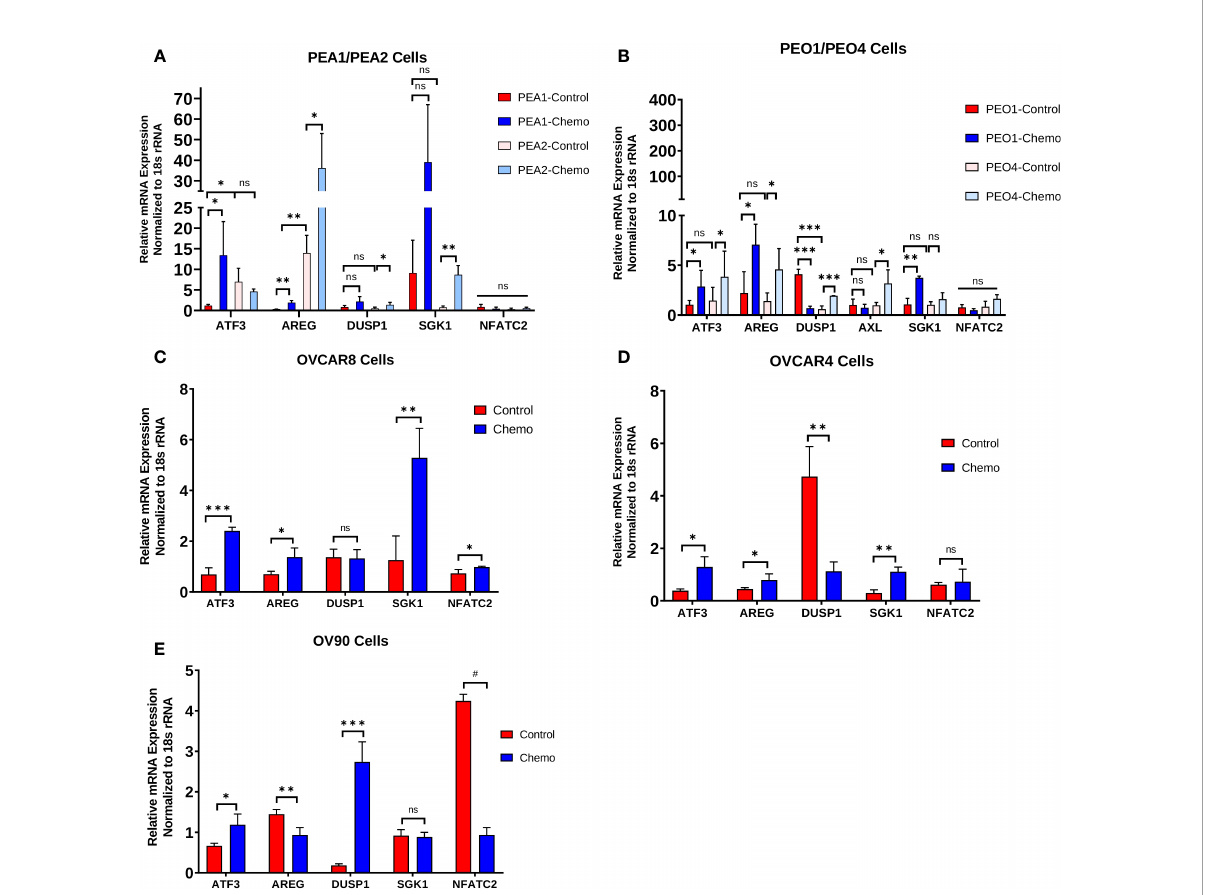
FIGURE 3 Chemotherapy-induced changes observed in human tumors are also evident in HGSOC cell lines and are associated with the chemoresistant phenotype. ATF3, AREG, DUSP1, SGK1 , and NFATC2 gene expression in (A) matched platinum-sensitive/resistant PEA1/PEA2 and cells, (B) matched platinum-sensitive/resistant PEO1/PEO4 cells, (C) OVCAR8 cells, (D) OVCAR4 cells, and (E) OV90 cells treated with 100 m M carboplatin and 10 nM paclitaxel for 48 h, measured by qPCR. Signi fi cance was determined by 1-tailed, unpaired student t test.